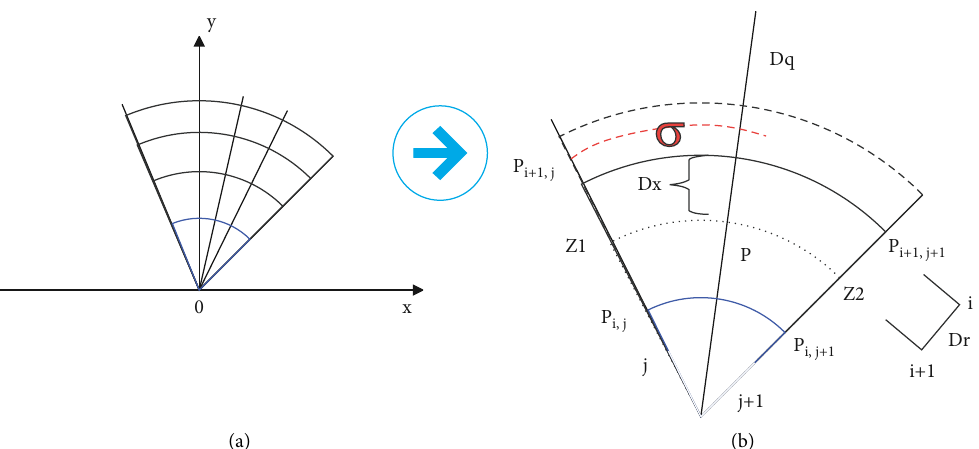
Figure 4: Enlarged image. (a) Sector scan. (b) Partially enlarged image.